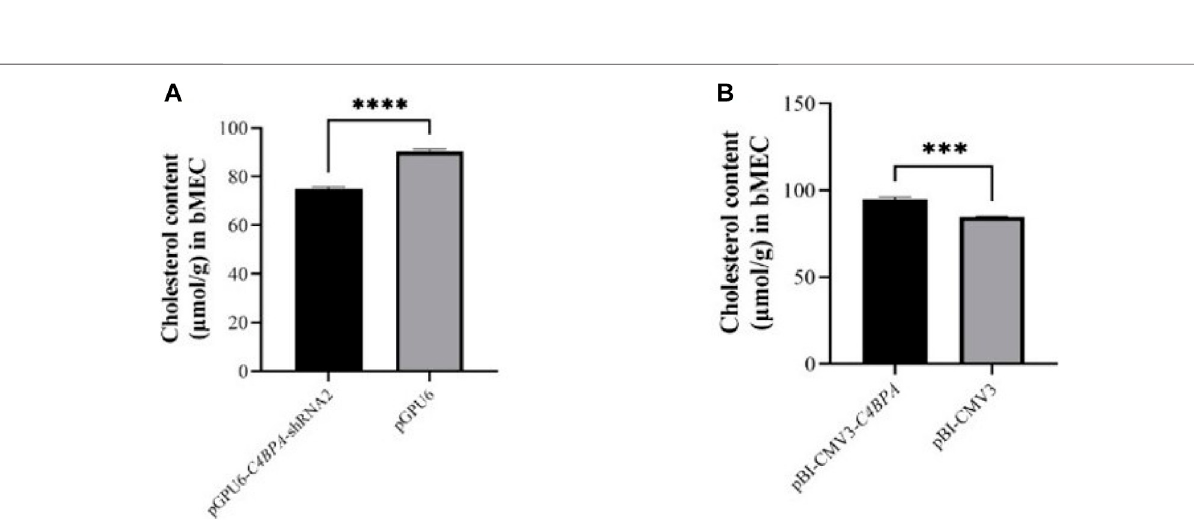
FIGURE 8 | (A) The relative content of triglycerides in bMECs after transfection with pGPU6- C4BPA -shRNA2. (B) The relative content of triglycerides in bMECs after transfection with pBI-CMV3-